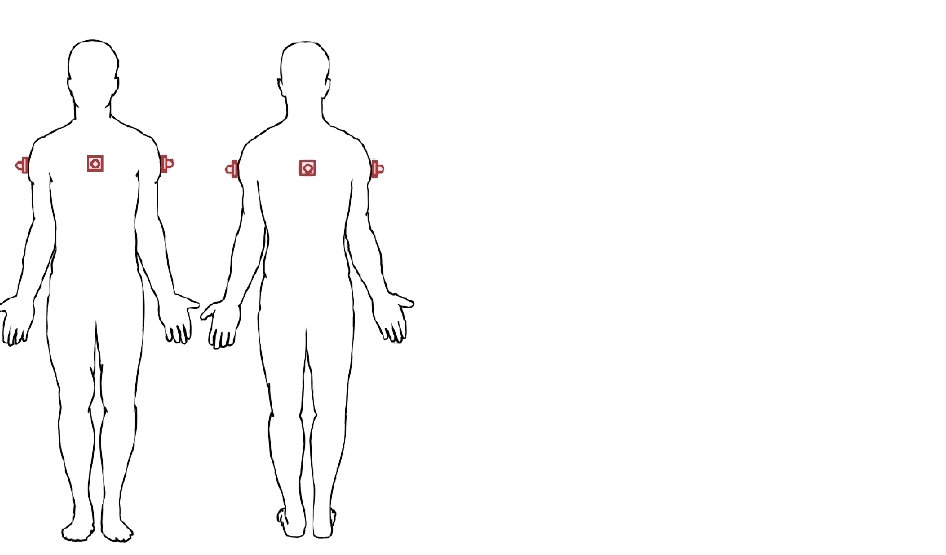
Figure 8. Representation of the ultrasonic sensor disposition for the environmental perception evaluation.